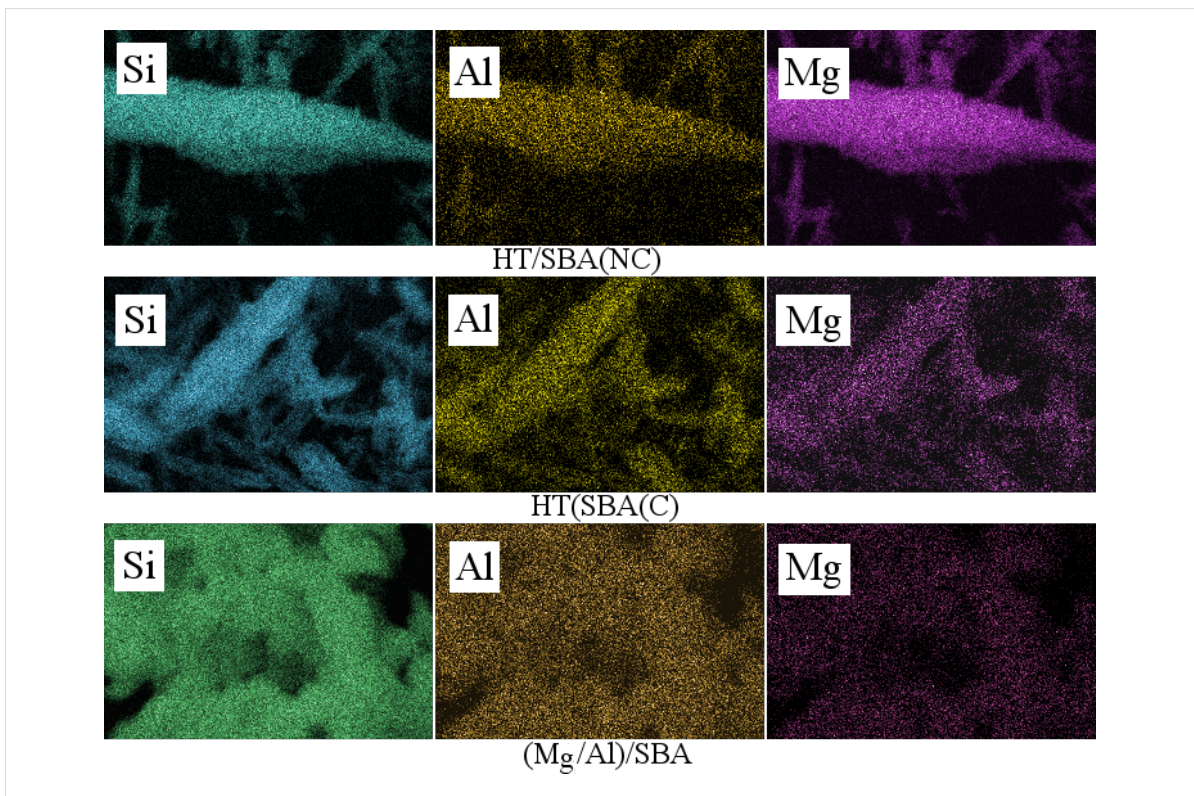
Figure 4: Energy dispersive X-ray (EDX) mapping analysis of composites.